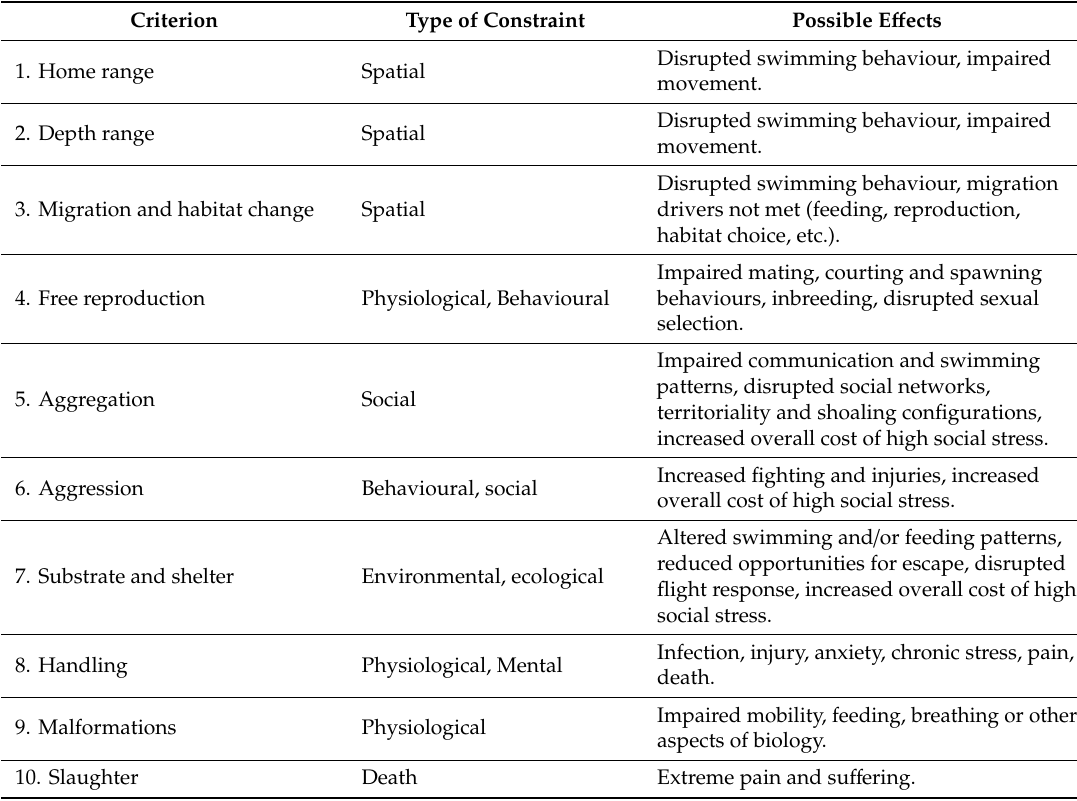
Table 1. Description and rationale of criteria used in the short profiles of the FishEthoBase www.